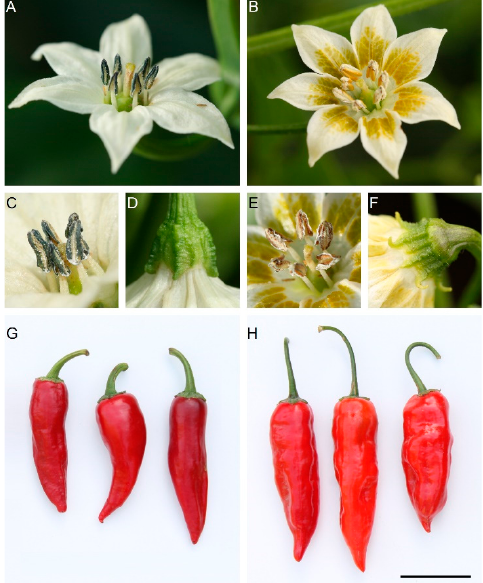
Figure 5. Flowers and fruits of Chilean landraces of chili pepper. ( A ) Flower of cacho de cabra with details of anthers ( C ) and calyx ( D ). ( B ) Flower of chileno negro with details of anthers ( E ) and calyx ( F ). ( G ) Fruits of cacho de cabra . ( H ) Fruits of chileno negro (scale bar = 5 cm). Morphological fruit traits changed significantly among fields (Table